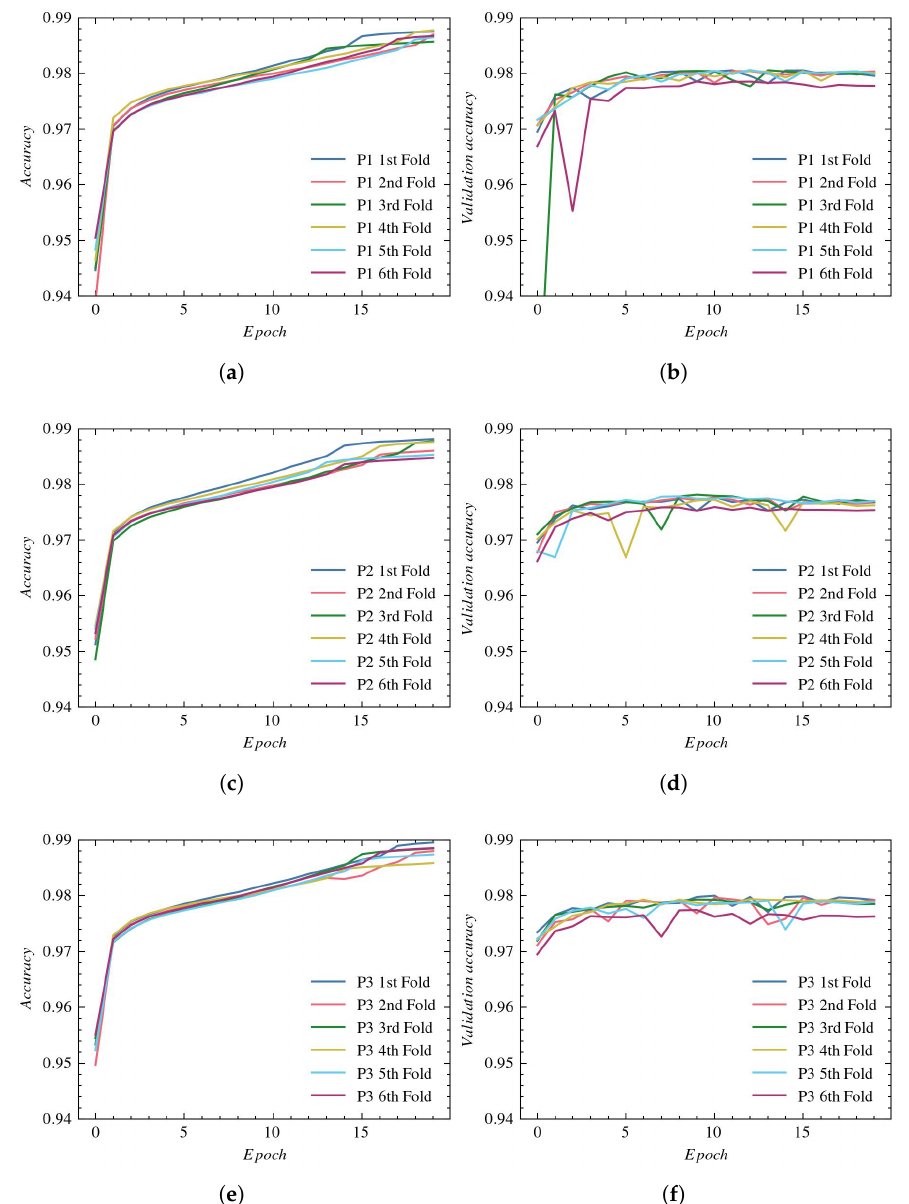
Figure 10. Accuracy plots for BCDU-Net architecture: ( a ) training using P1, ( b ) validation using P1, ( c ) training using P2, ( d ) validation using P2, ( e ) training using P3, and ( f ) validation using